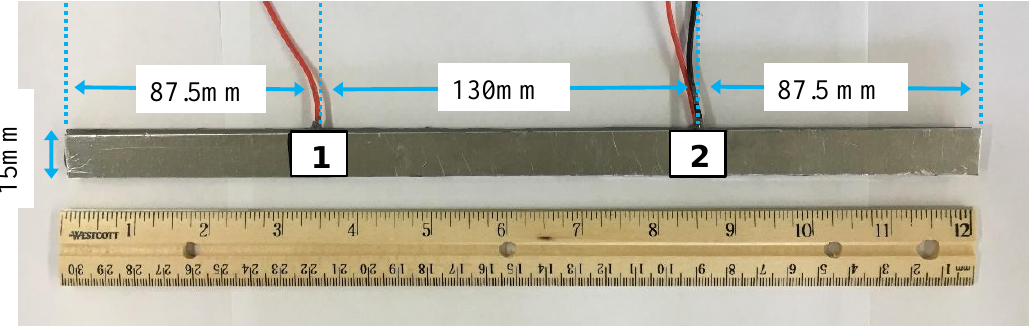
Figure 4. Fully prepared sample with two square d35 PZTs embedded within the bondline with their polling direction along the length of the aluminum sheet.